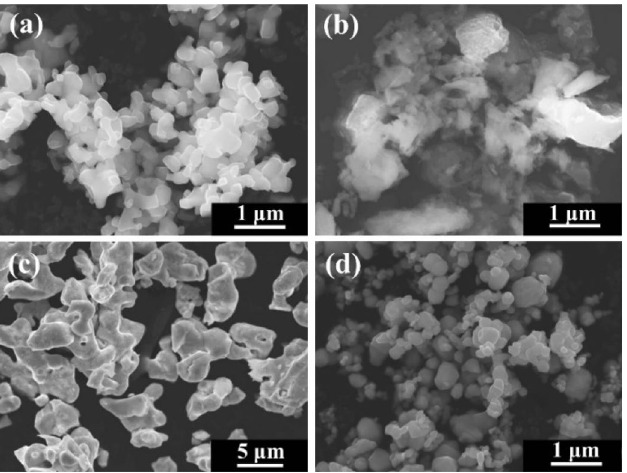
Figure 2. SEM images of the raw ( a ) Mo, ( b ) Si, ( c ) MoB, and ( d ) TiC